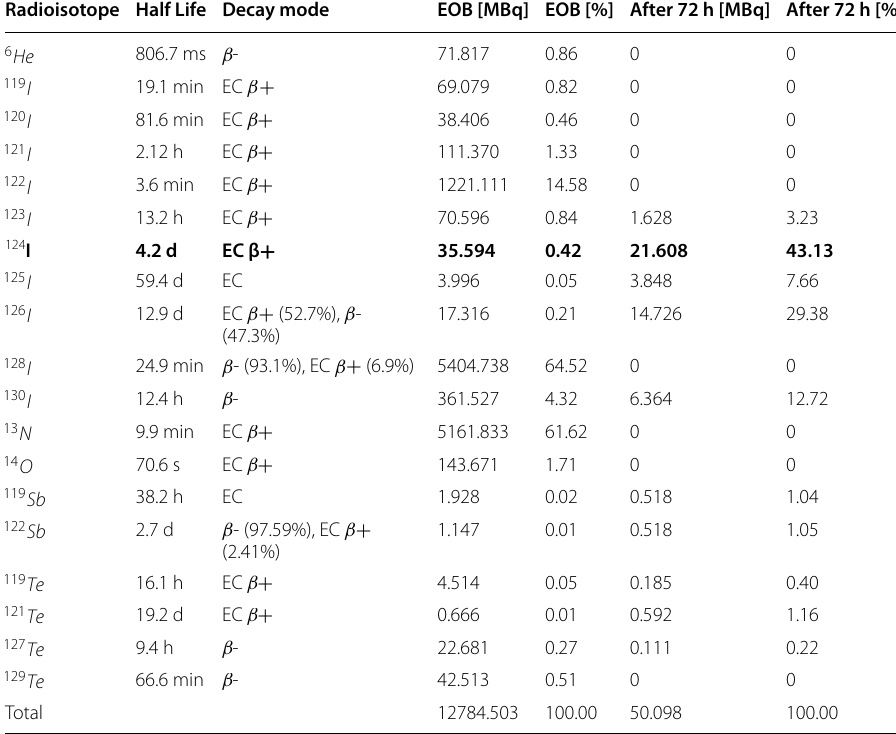
The production parameters: natural TeO 2 , 18 MeV protons moderated to 14.8 MeV with 0.2 mm Havar, the proton current of 15 μA. The activity values at the end of bombardment (EOB) and the activity values after 72 hours since the end of bombardment are presented. 124 I is highlighted in bold